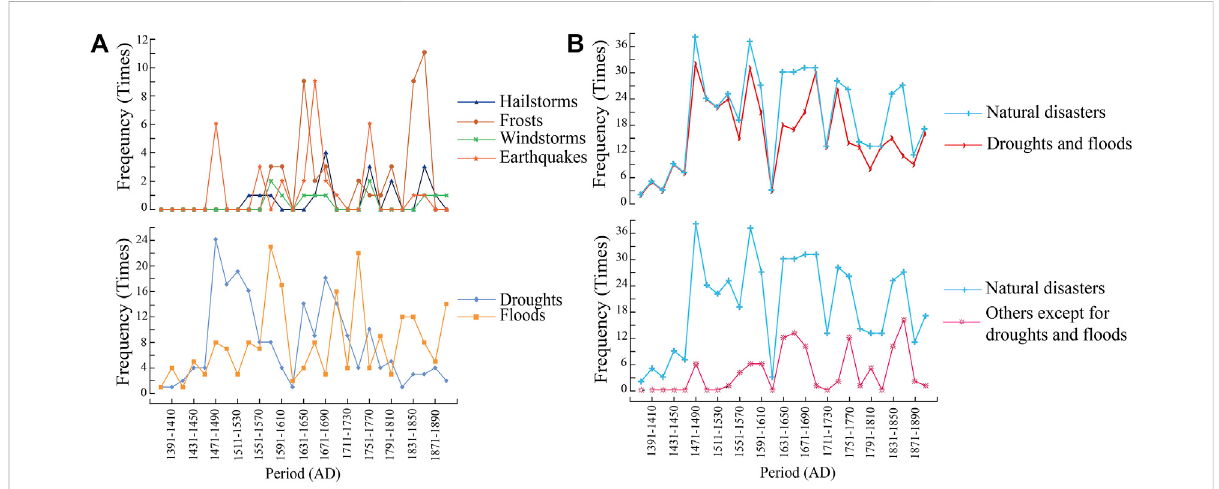
FIGURE 3 Frequency curves of the natural disasters in the Huizhou region during the Ming and Qing dynasties. (A) Inter-annual frequency variation of the natural disasters. (B) Comparison of the inter-annual frequency variation of fl oods, droughts with natural disasters, and other disasters with natural